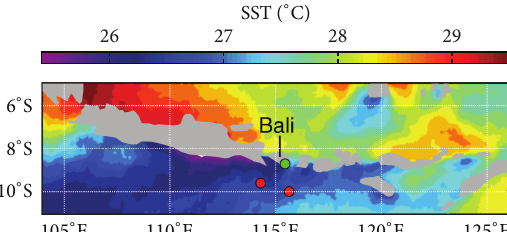
Figure 4: Sea surface temperature (SST) during September-October 2004, coincident with tagging period. Deployment (green) and pop-off (red) locations for Fishes A and